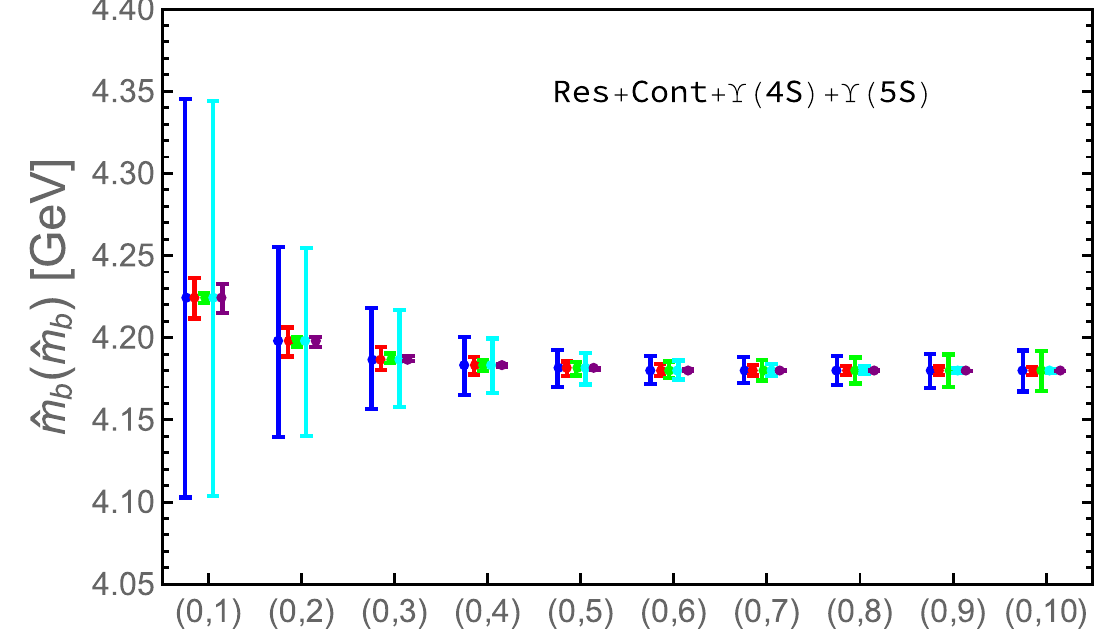
Fig. 3 Results for ˆ m b ( ˆ m b ) using different combinations of moments, where we added the ϒ( 4 S ) and ϒ( 5 S ) states explicitly to the ansatz in Eq. (5), as described in the text. Blue bars represent the full error, red bars are from the experimental uncertainties in the resonance